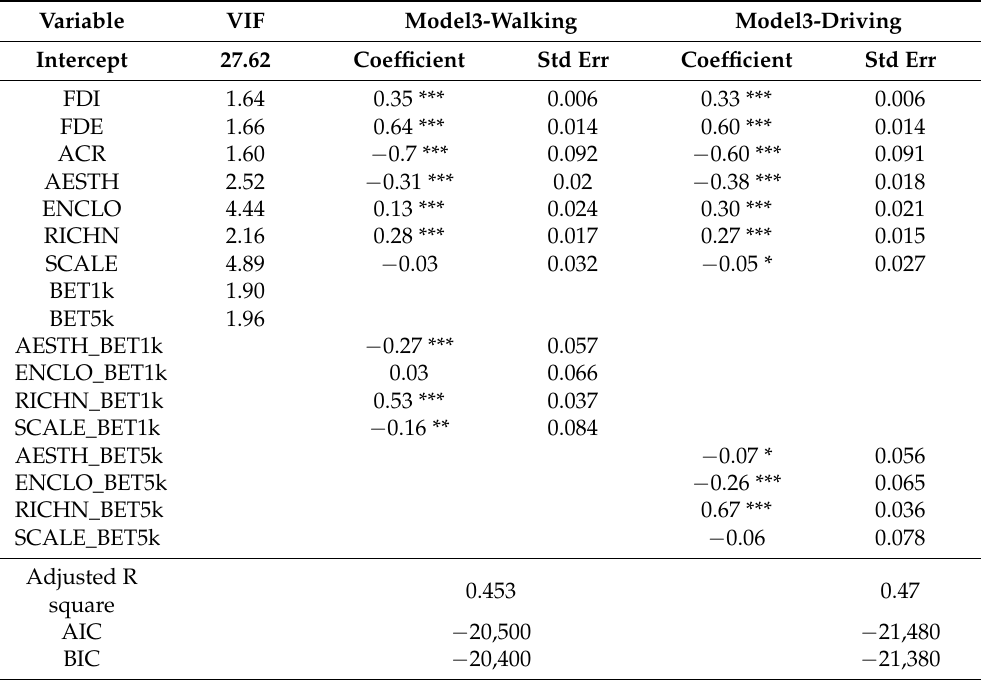
Table 3. Comparison of the dynamic perception model of walking and driving with the variables of VIF <